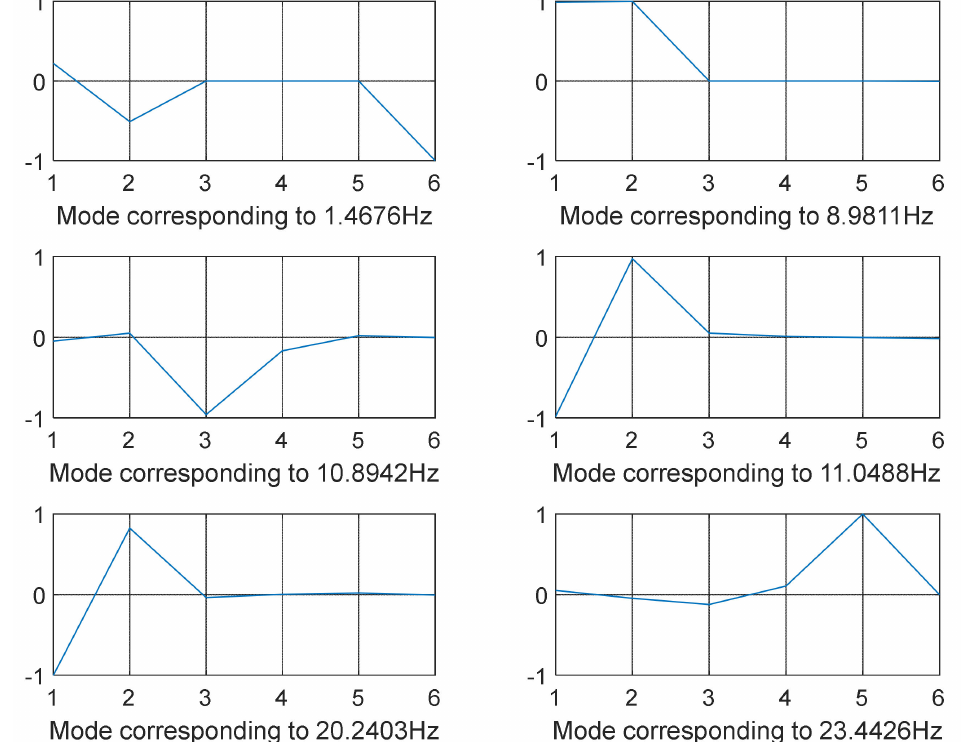
Figure 7. SQP-optimized mode shapes 1–6 (12-DOF model—shaking loads